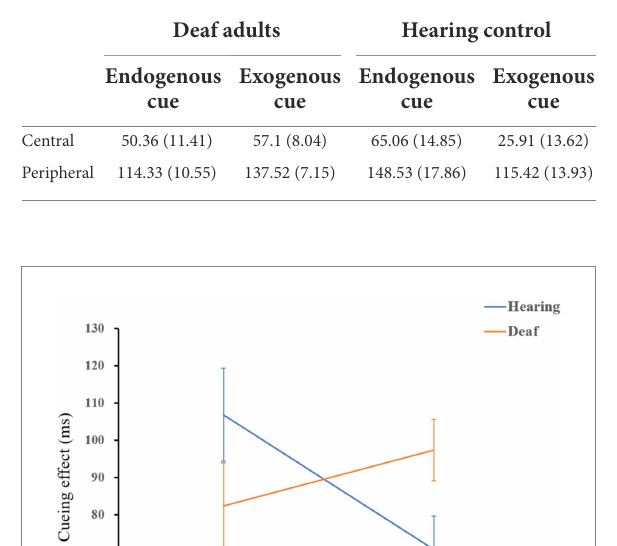
TABLE 1 Mean cueing effect (ms) and standard error of deaf and hearing groups on stimuli from different cue types and locations when there is a short ISI.